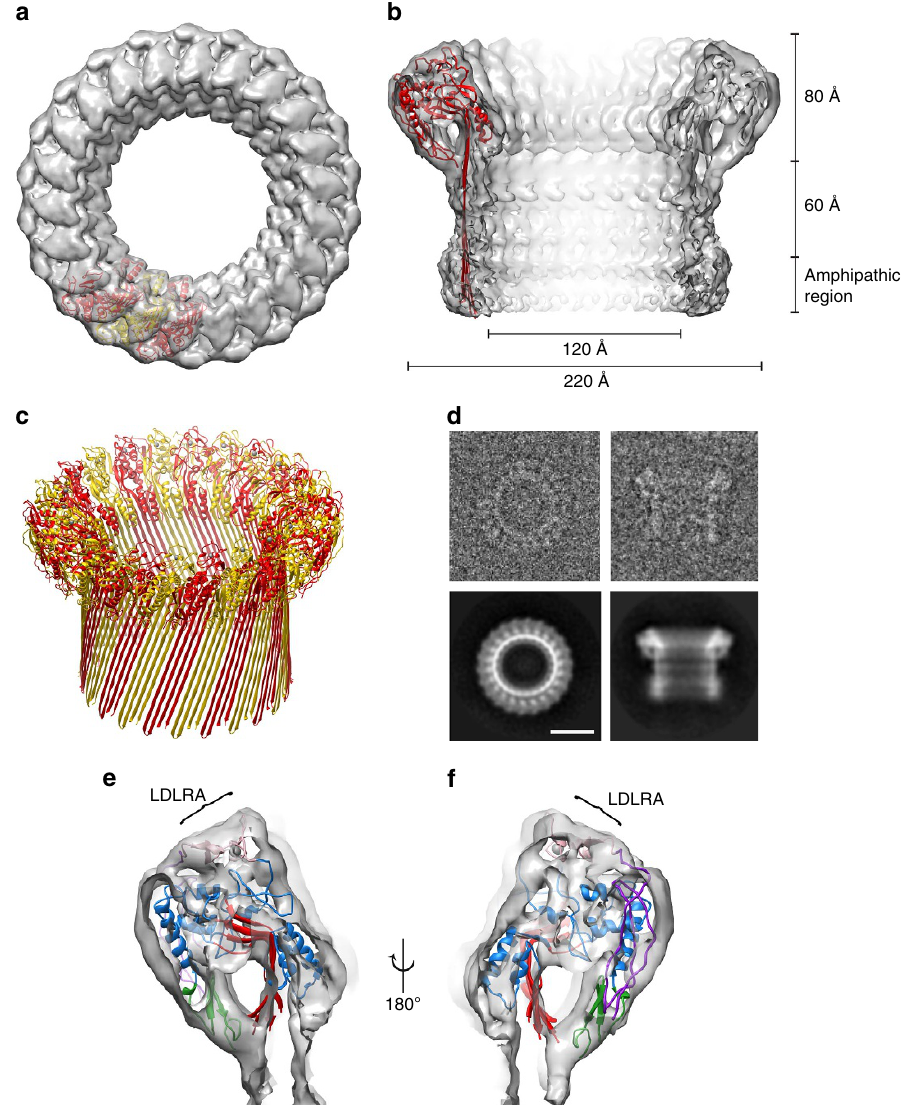
Figure 1 | The structure of poly-C9. ( a ) Top–down view of a C9 trimer in the poly-C9 map and ( b ) cut through of the poly-C9 map with cartoon (red) of the poly-C9 model. Approximate dimensions and the predicted amphipathic region are indicated. ( c ) Cartoon of the full poly-C9 pore (alternating red and yellow monomers). The barrel is best modelled with the architecture S ¼ n/2 (ref. 42). ( d ) Cryo-EM end and side views of poly-C9 in individual images (top) and class averages (bottom). ( e , f ) With the exception of the mobile region of the MACPF domain (which in poly-C9 has rearranged in order to form the barrel), the crystal structure of C6 (PDB ID: 3T50) fits well into the map, with TMH1 and TMH2 omitted for clarity. In this figure the conserved b -sheet of the MACPF domain is in red, the body of the MACPF domain is in blue, the EGF domain in green, the TSP1 domain in purple and the LDLRA domain in pink